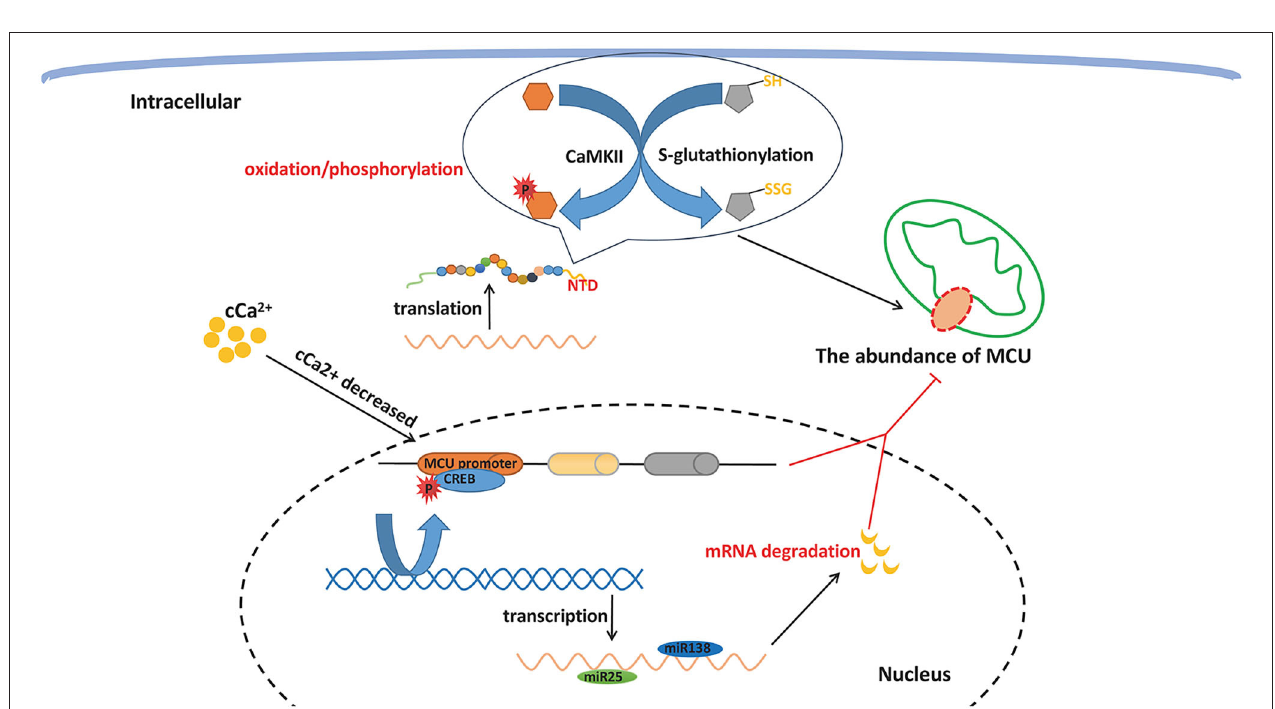
FIGURE 1 | The structure of the MCU complex. This compound, localized at the inner membrane of the mitochondria, consists of the pore-forming subunit and regulator subunits, including MICU1, MICU2, EMRE, MCUR1, and MCUb. The most important function of MCU is mediating mitochondrial calcium uptake.